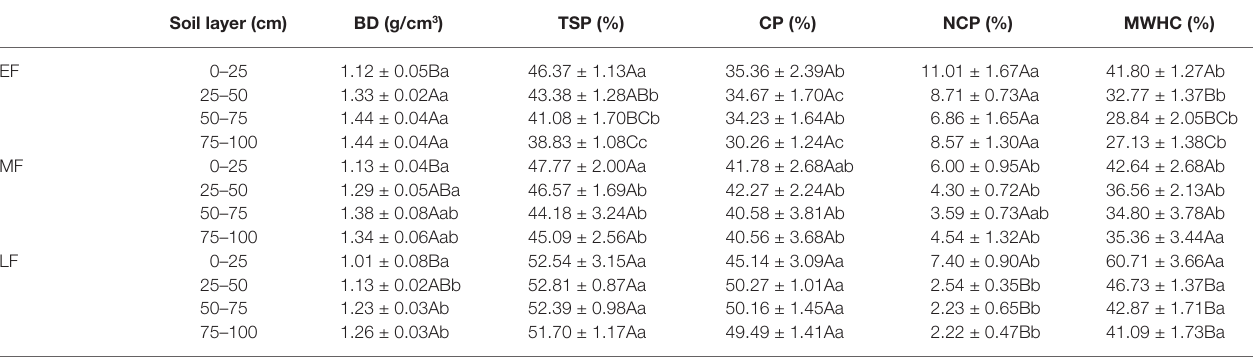
BD, bulk density; MWHC, maximum soil water holding capacity; TSP, total soil porosity; CP, capillary porosity; NCP, non-capillary porosity; EF, broadleaf–conifer mixed forest; MF, broad-leaved forest; LF, old-growth forest. Lowercase letters represent statistically significant differences among different stand types in the same soil layer. Capital letters represent statistically significant differences among different soil layers in the same stand type (Duncan’s tests, p < 0.05).